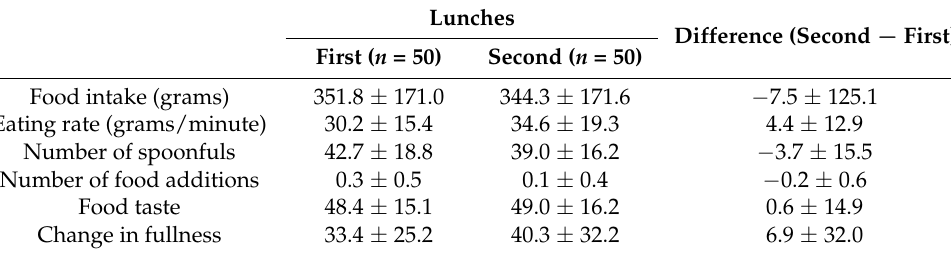
Table 3. Mean values of meal parameters in the two lunches and the difference between them 1